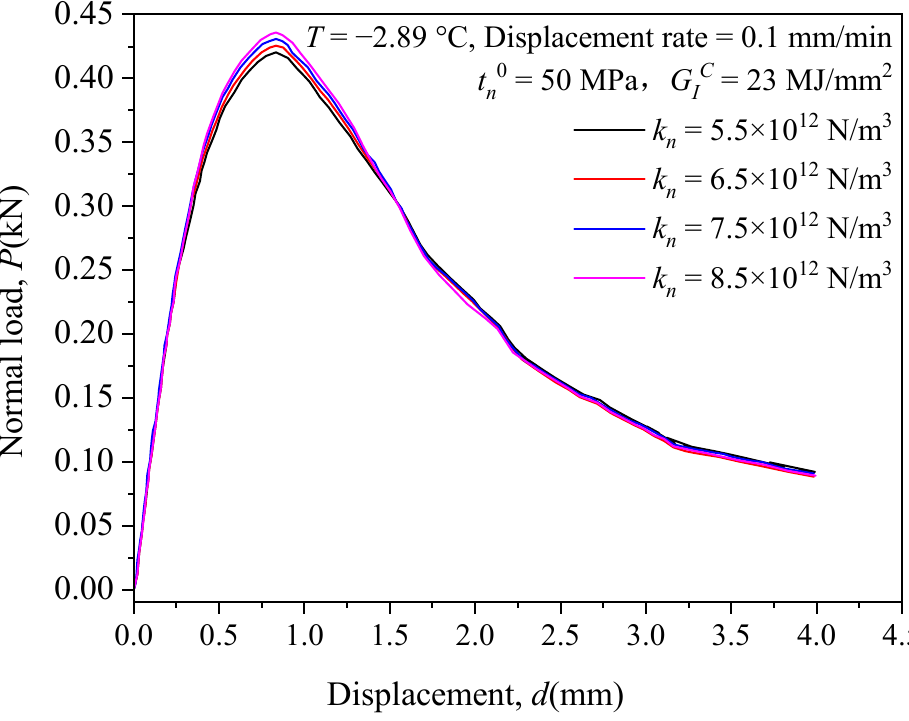
Figure 3. Normal load-displacement relationship curves for different normal stiffnesses k n